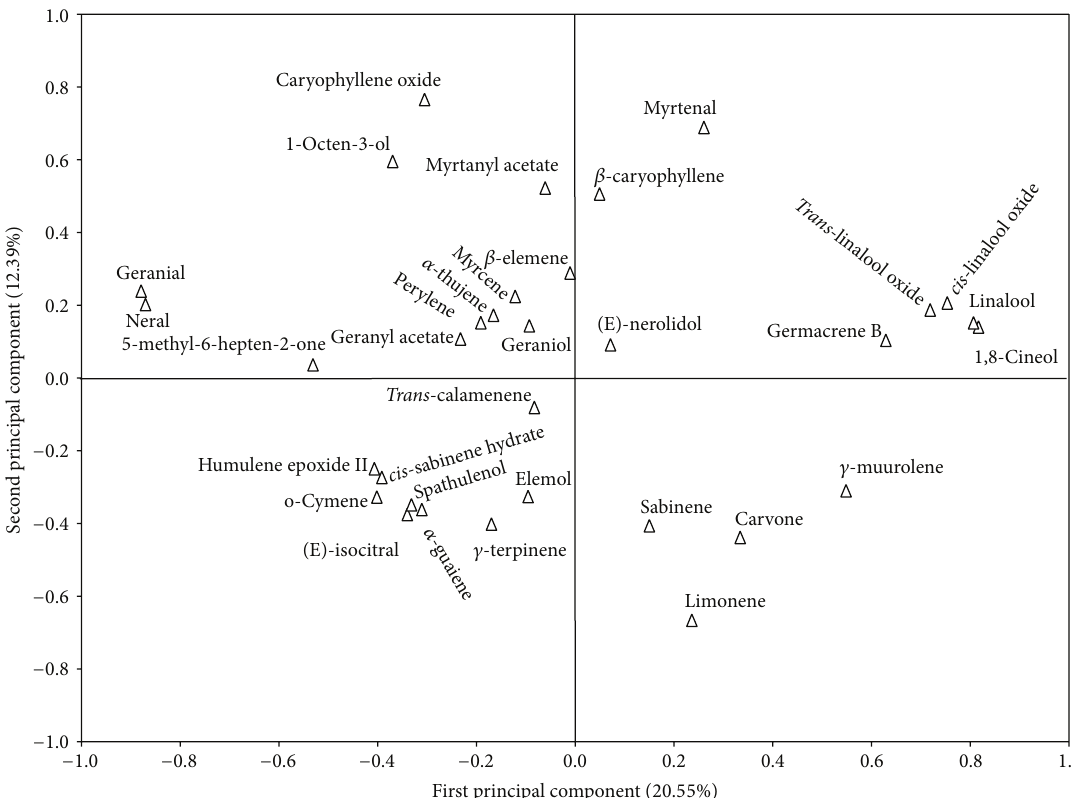
Figure 3: Distribution of chemical compounds in the essential oils of L. alba in relation to the first and second principal components, based on the principal component analysis